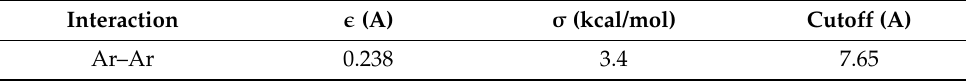
Table 2. Parameters of Lennard–Jones potential for argon-argon interaction.